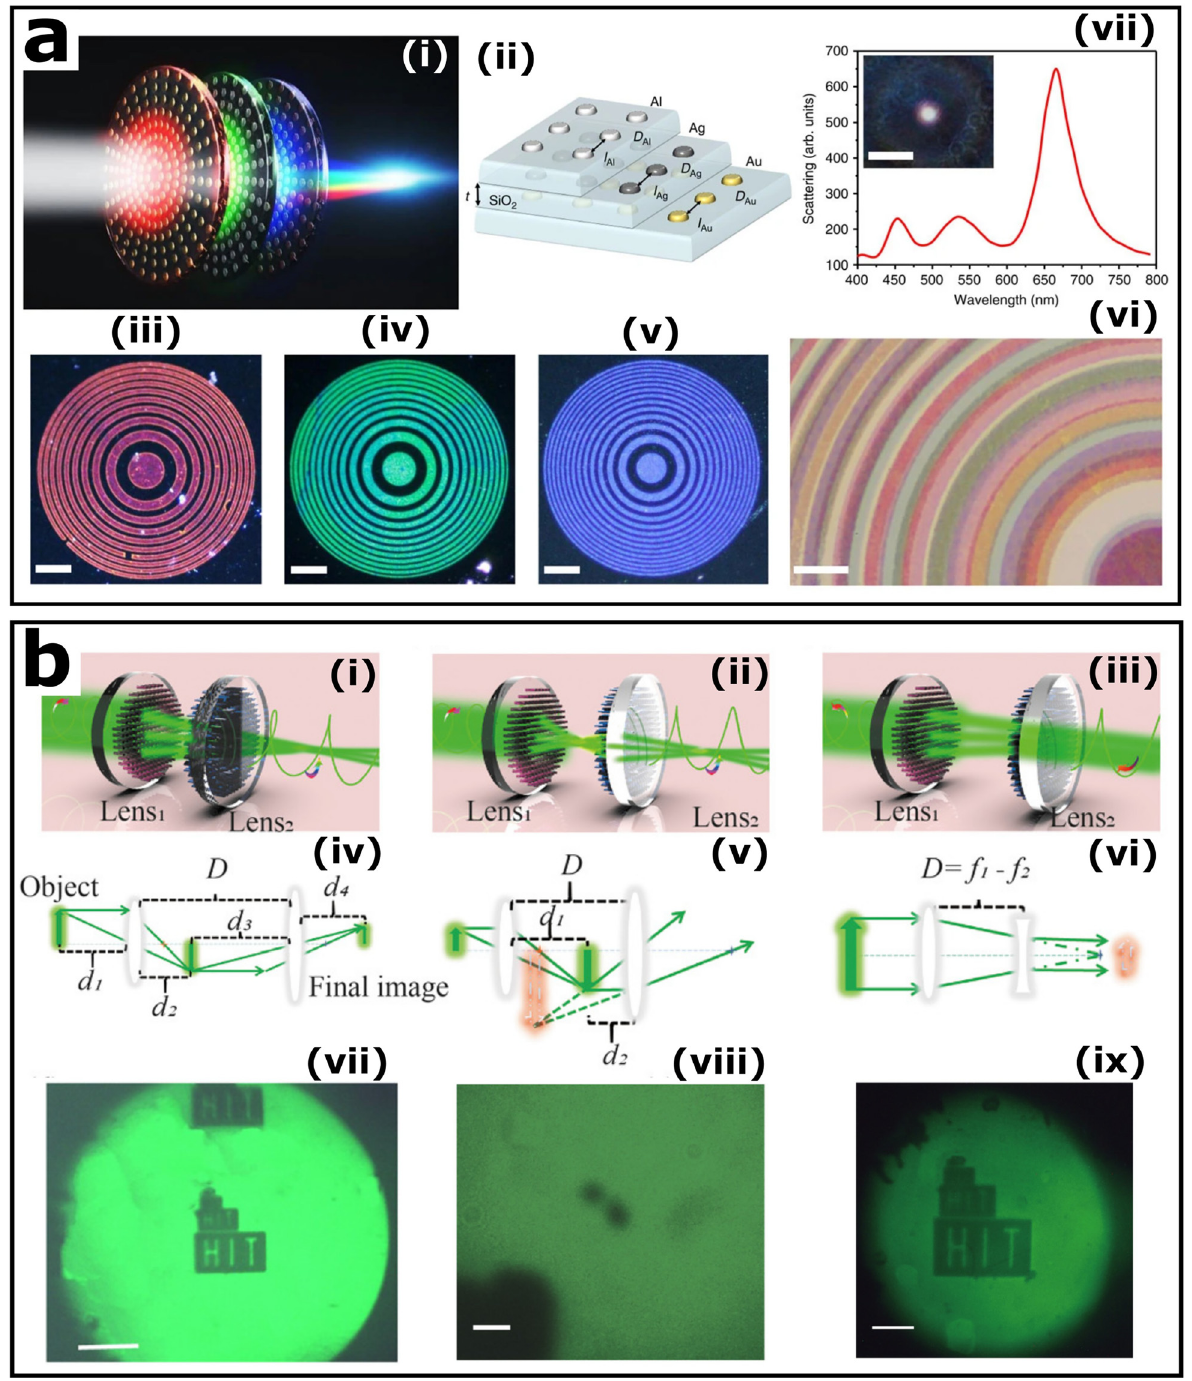
Figure 4: Multilayered metasurfaces. (a): (i) A rendered picture of the three-layer lens. (ii) Schematic of the layered structure. (iii – v) Dark-field images of the single-layer lens elements. Scale bar: 35 µm. (vi) Bright- fi eld transmission image of the three-layer lens. Scale bar: 10 μ m. (vii) White focal spot and corresponding spectrum. Scale bar: 20 µm. Reproduced from ref. [24] under a Creative Commons Attribution 4.0 International License, Springer-Nature.(b):Theschematicsofthemetalensdoubletforthefunctionsofacameralens(i),acompoundmicroscope(ii),andtheGalileo telescope (iii). The corresponding 2D schematics (iv – vi) and the fi nal images (vii – ix) are illustrated in bottom panels of (i – iii). Scale bar: (vii) 30 µm, (viii) 3 µm, (ix) 100 µm. Reproduced with permission from ref. [79]. Copyright 2020,